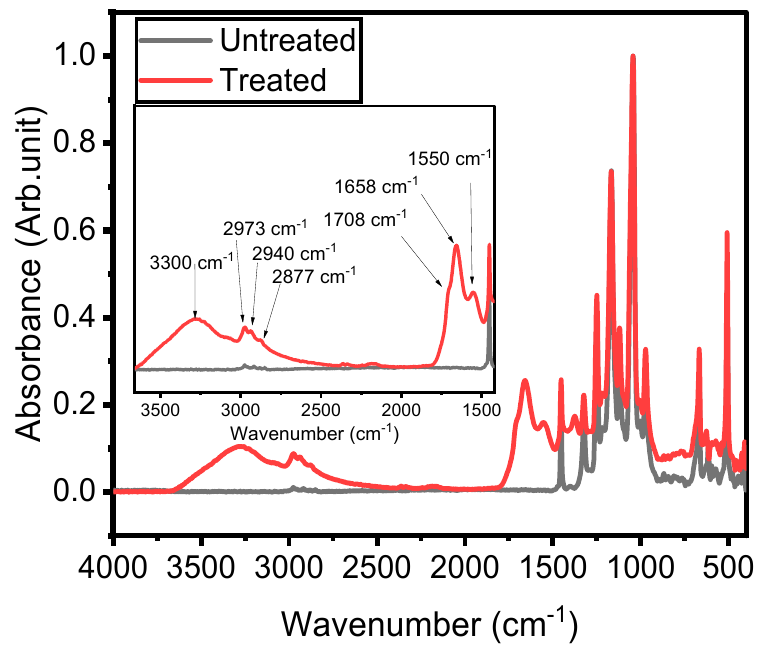
Figure 8. Fourier-transform infrared spectra of untreated ETFE and of a typical plasma-treated ETFE sample.